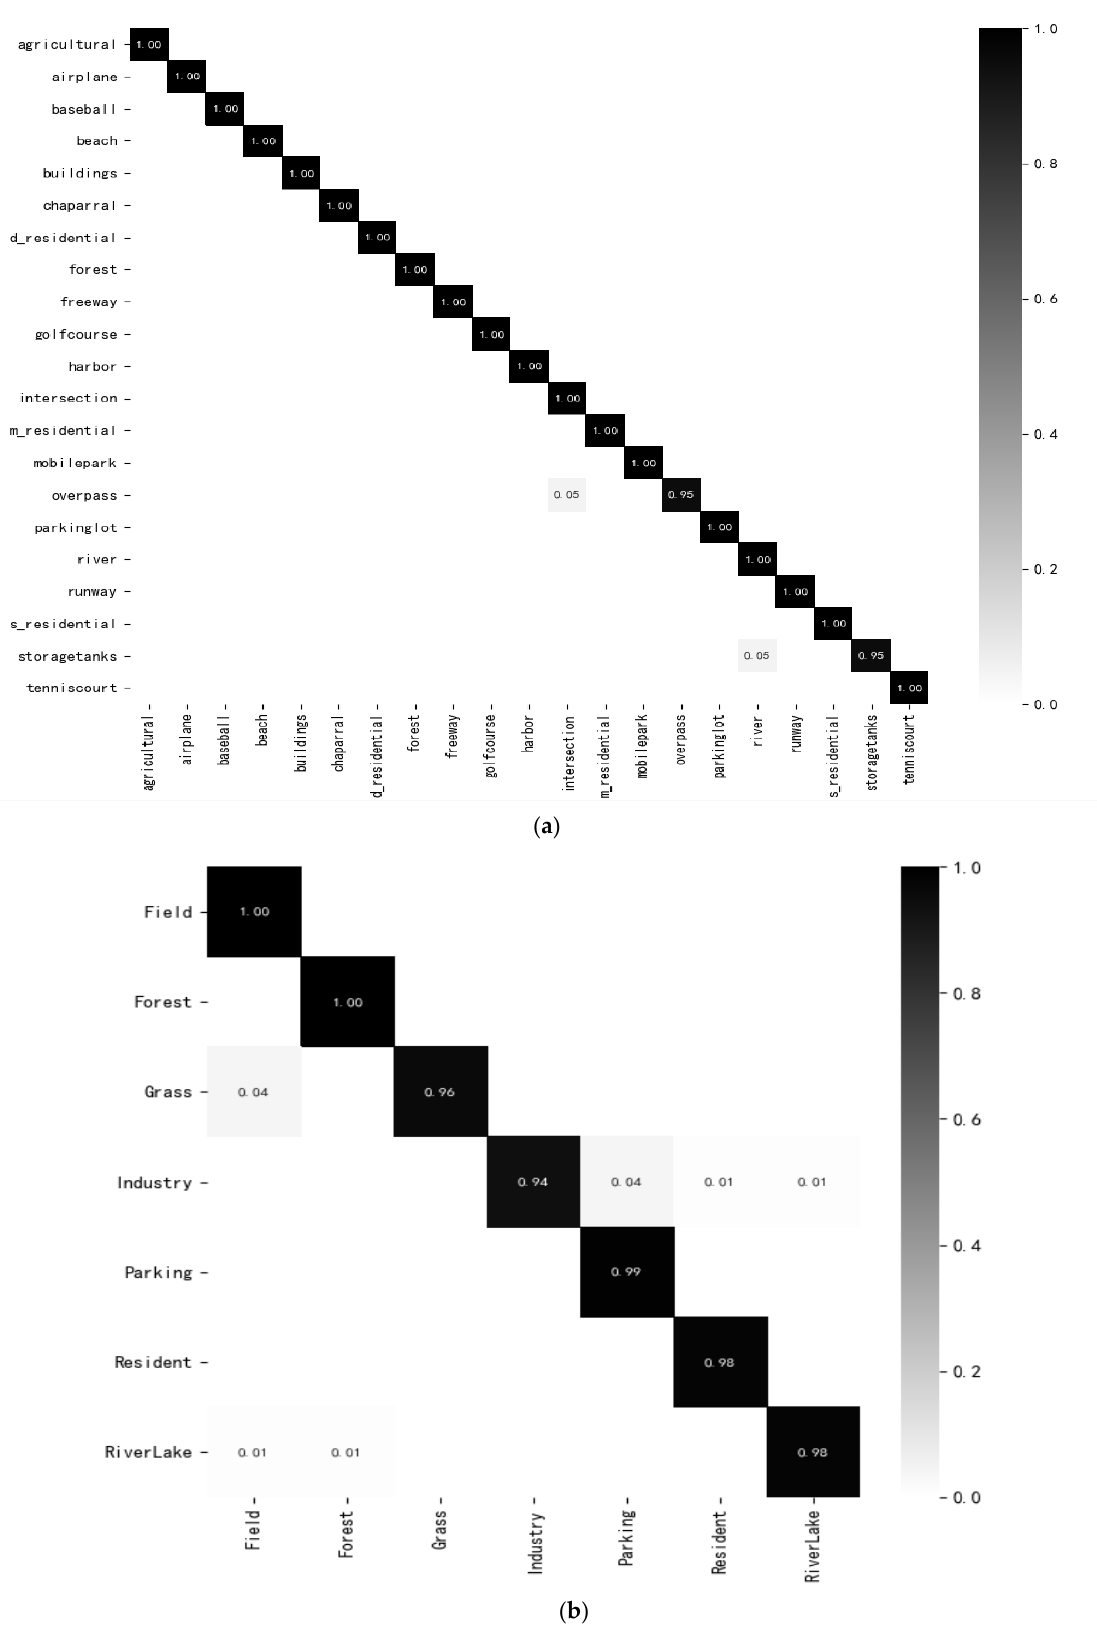
Figure 5. Confusion Matrices of BMDF-LCNN Method on UC and RSSCN Datasets . ( a ) Confusion matrix obtained on 80/20 UC datasets. ( b ) Confusion Matrix on 50/50 RSSCN Dataset.